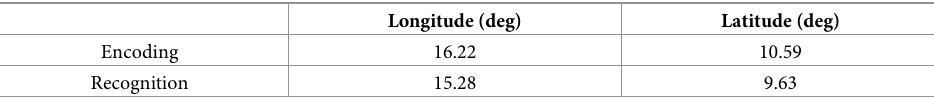
Table 2. Spreads (median standard deviations) of eye positions in head-centered